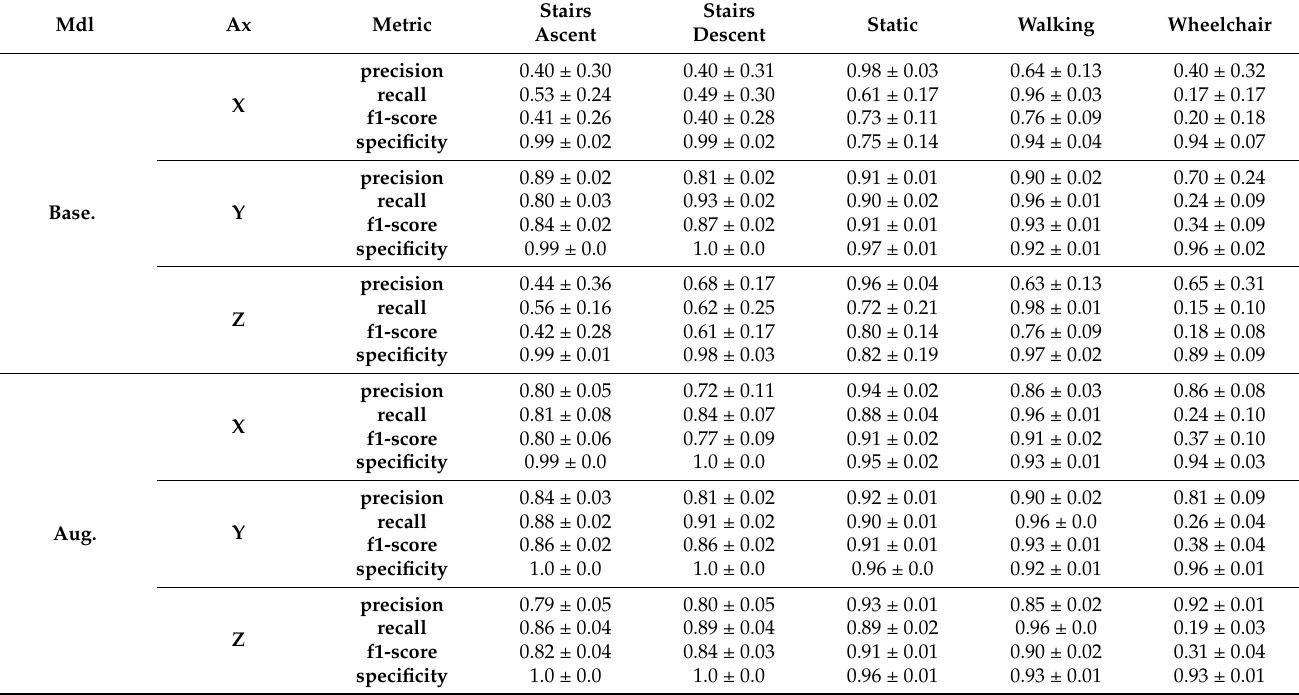
Table A8. Single class results of baseline and augmented model for the fully-rotated test set on every axis. Considered data: SHS